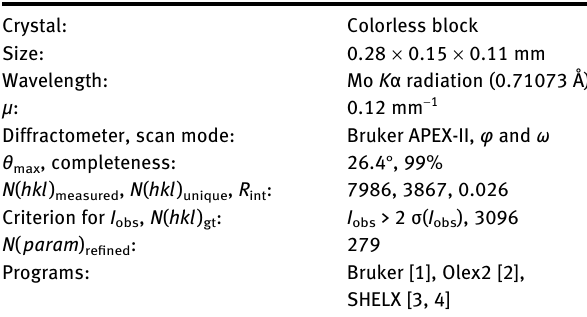
Table  : Data collection and